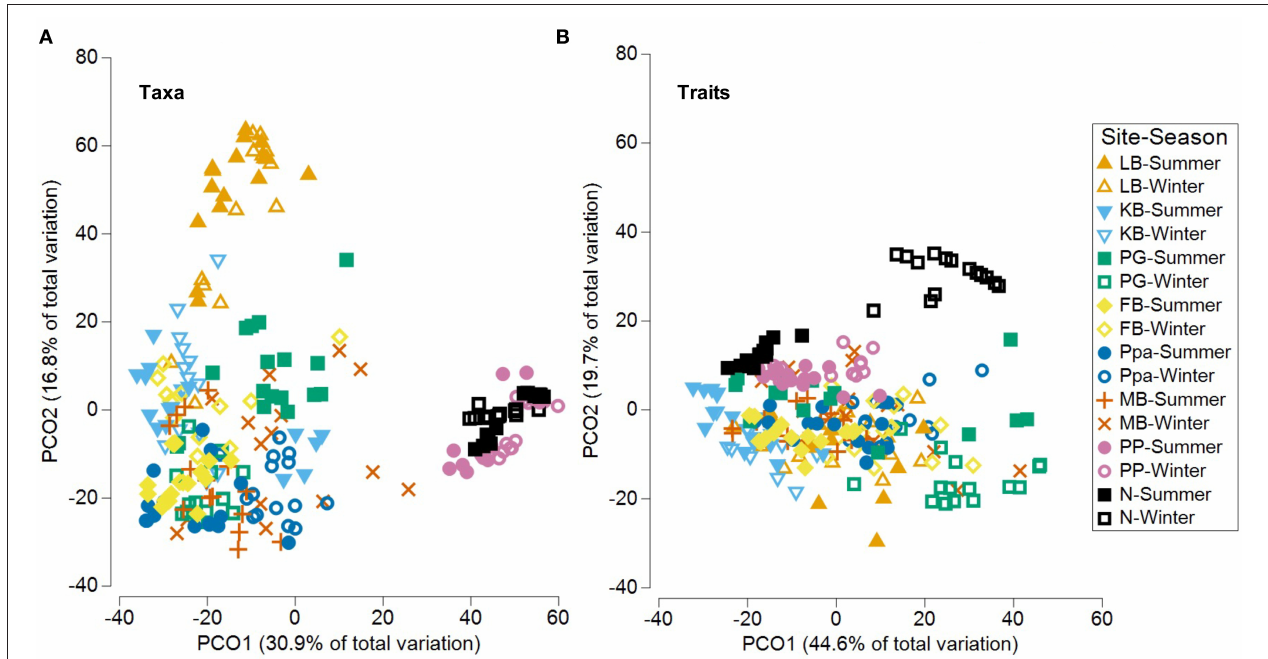
FIGURE 7 | PCO (Principal Coordinates Ordination) plots for benthic assemblages across sites and seasons based on the (A) taxonomic and trait (B) composition. LB, long beach; KB, kellidie bay; MB, middle beach; PPa, port parham; PG, port germein; FB, fisherman bay; PP, pelican point; N, noonameena.